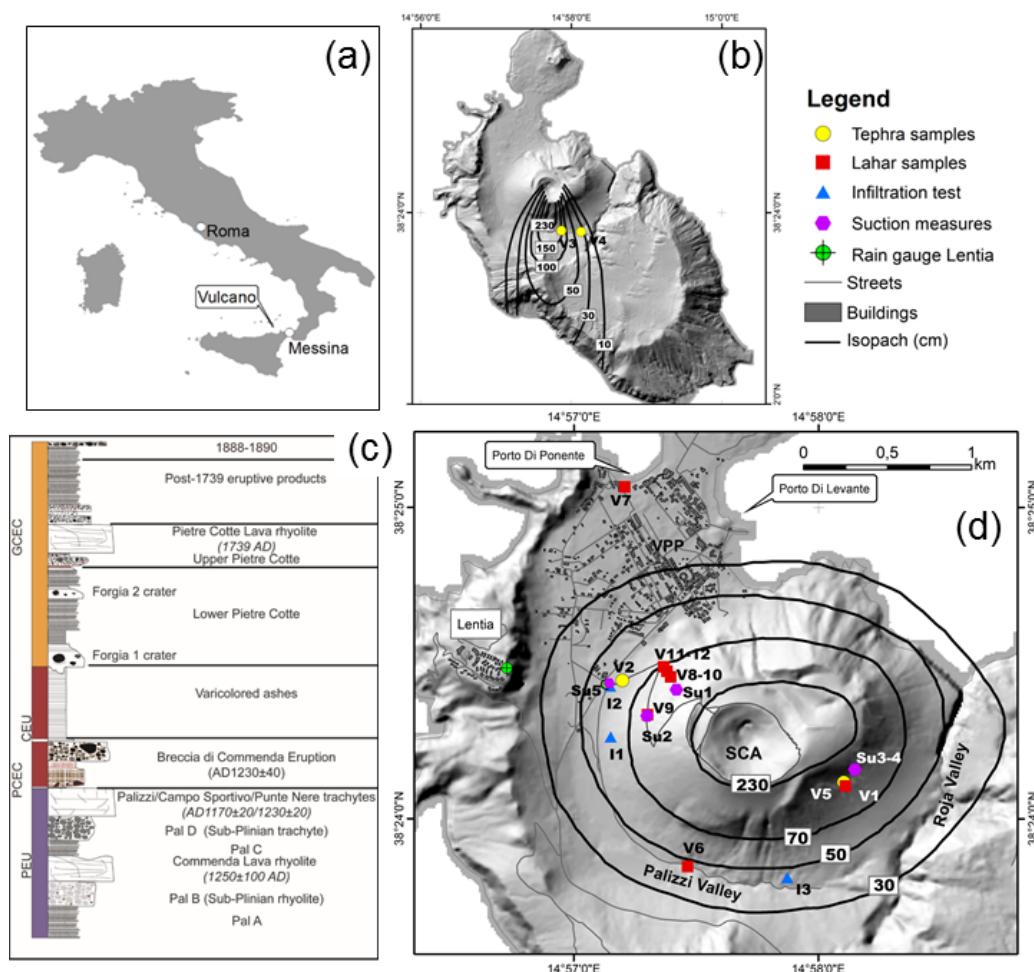
Figure 1. Overview of the study area. (a) location of the island of Vulcano in Italy. (b) Isopach map on a shaded relief of Vulcano island of the cumulative tephra fallout PAL-D deposit (after Di Traglia, 2011). (c) Simplified stratigraphy of the last 1000 years of the La Fossa volcano based on Di Traglia et al. (2013) and De Astis et al. (1997, 2013) (see Table 1 for more details). (d) Isopach map of the cumulative 1888–1890 tephra fallout deposit (after Di Traglia, 2011) and sample locations. Sample names refer to V samples of tephra fallout (yellow circles) and lahars (red squares), I to infiltration measures (blue triangle), and Su to suction measurements (pink diamond). SCA: summit cone area. VPP: Vulcano Porto Plain. The rain gauge of Lentia is also shown (green